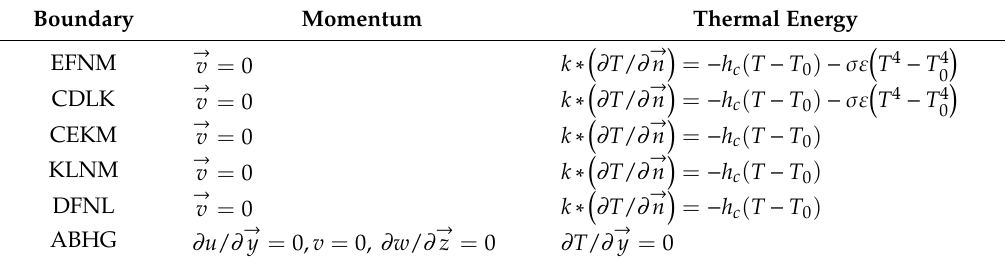
Figure 6. Schematic diagram of the boundary conditions.